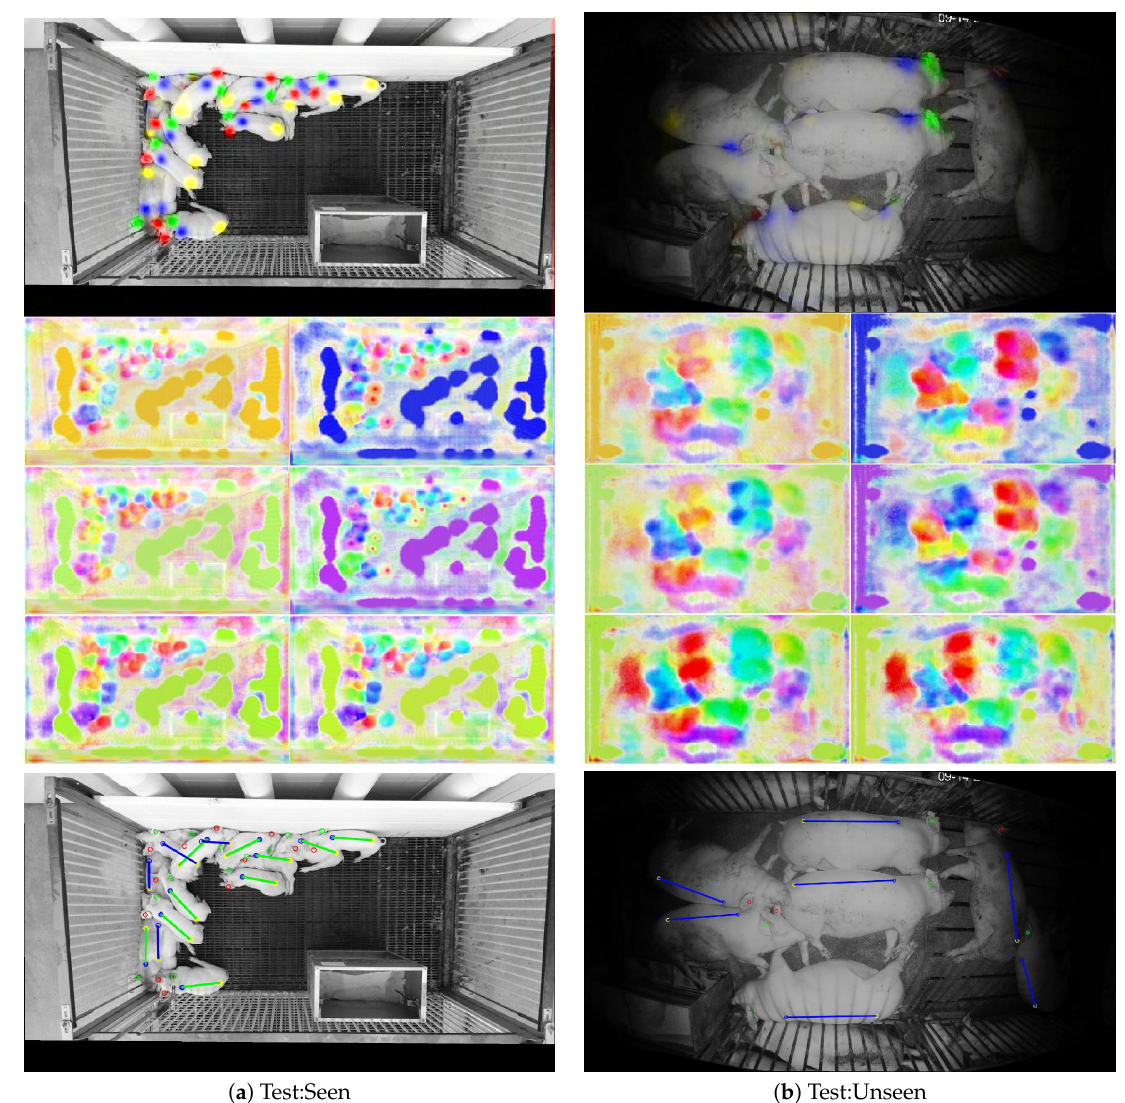
Figure 12. Examples of unsuccessful instance detection from both the test:seen set ( a ) and the test:unseen set ( b ). The top images depict the first four channels of the neural network output. The middle image composed of six sub-images depicts the color-coded vector associations from the last 12 channels of the neural network output. The bottom images depict both ground truth locations and estimates using the following color coding: false negative (blue), and true positive